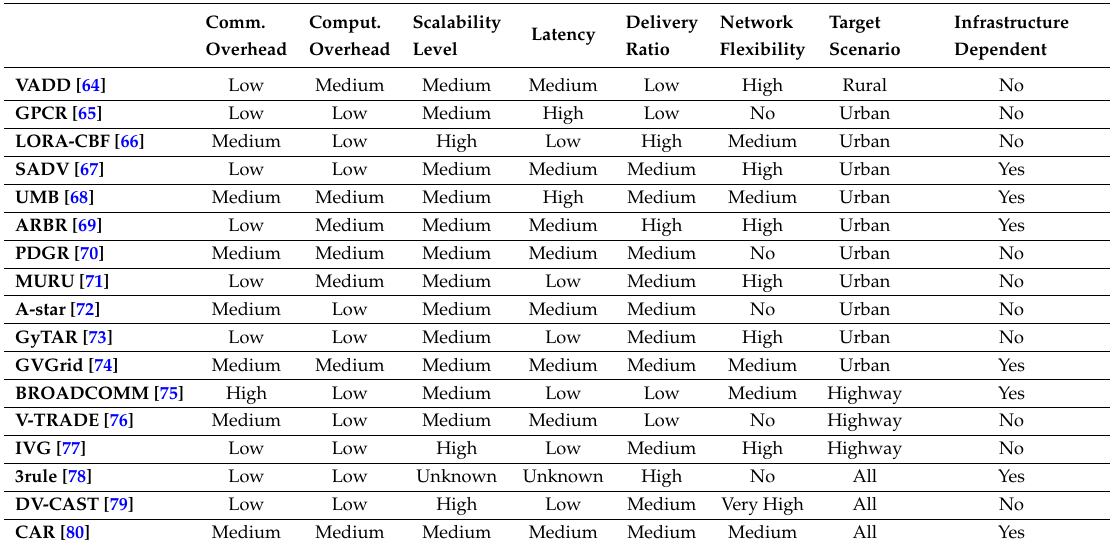
Table 2. Main characteristics of reviewed vehicular routing